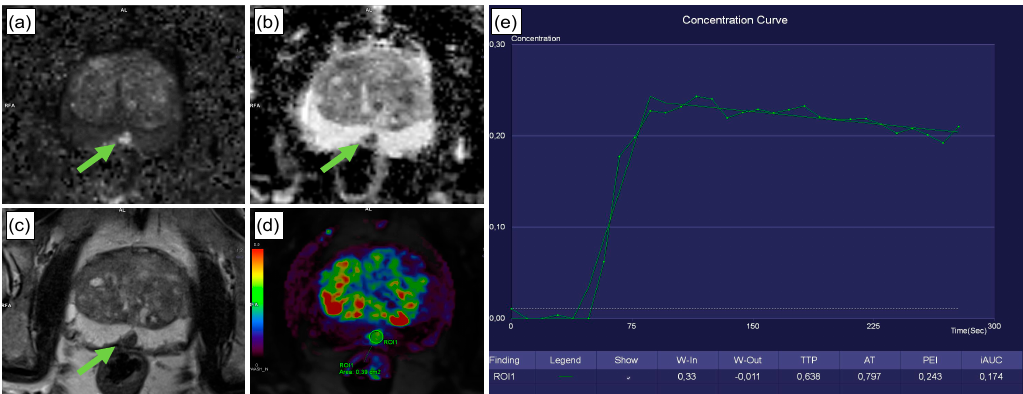
Figure 4. Clinical case from the testing set. This 74-year-old patient was referred to radiology for prostate MRI because of an increase in serum PSA levels to 8 ng/mL and the suspicion of prostate cancer. Multiparametric MRI revealed a 10 × 7 mm PI-RADS 4 lesion dorsally in the mid/apical peripheral zone (green arrow; classification according to PI-RADS v2.1 [6]). The lesion featured high signal intensity in DWI ( a ), along with a strong diffusion restriction in ADC ( b ). T2w axial images showed a signal decrease in the sharply delineated lesion ( c ). The lesion featured a steep wash-in curve, along with a decent wash out ( d,e ). Subsequent histopathology revealed scarred prostate tissue and few prostate glands with urothelial metaplasia, but no evidence of malignancy. The CADx correctly excluded malignancy for this peripheral zone PI-RADS 4 lesion, with a false negative rate of 3%. The patient received a follow-up examination 9 months later in which the lesion had remained unchanged.